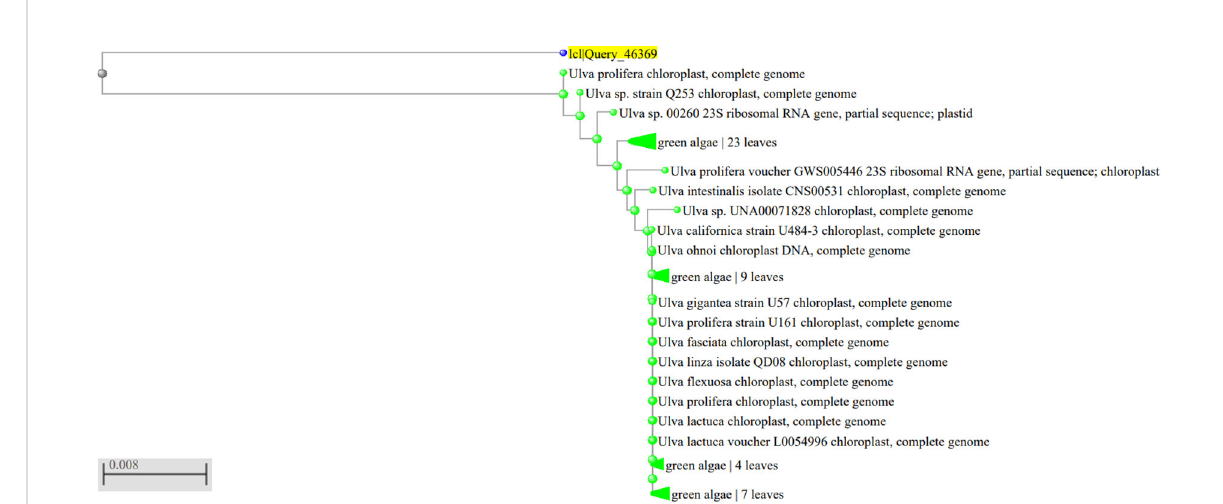
FIGURE 1 Neighbor-joining phylogenetic tree of green alga. The yellow highlighted sequence represents the green alga under investigation, while green circles highlight the closely related sequences.